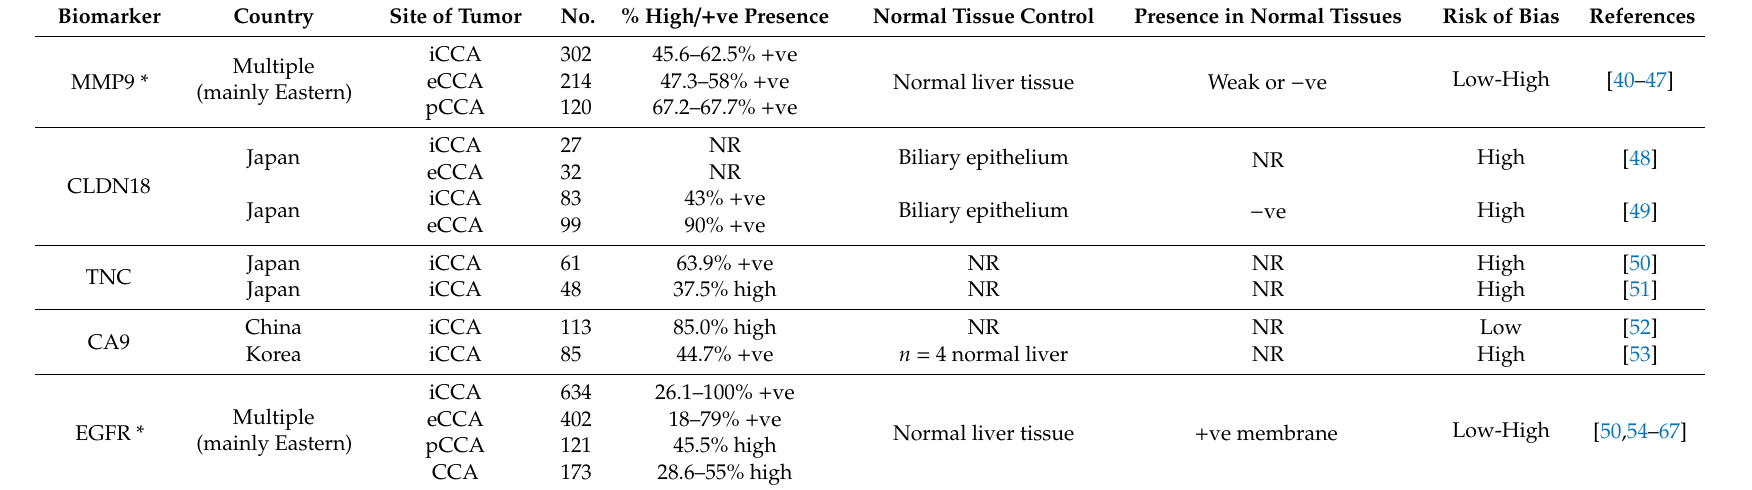
Table 3. Study characteristics of the top five selected candidate biomarkers for theranosis in